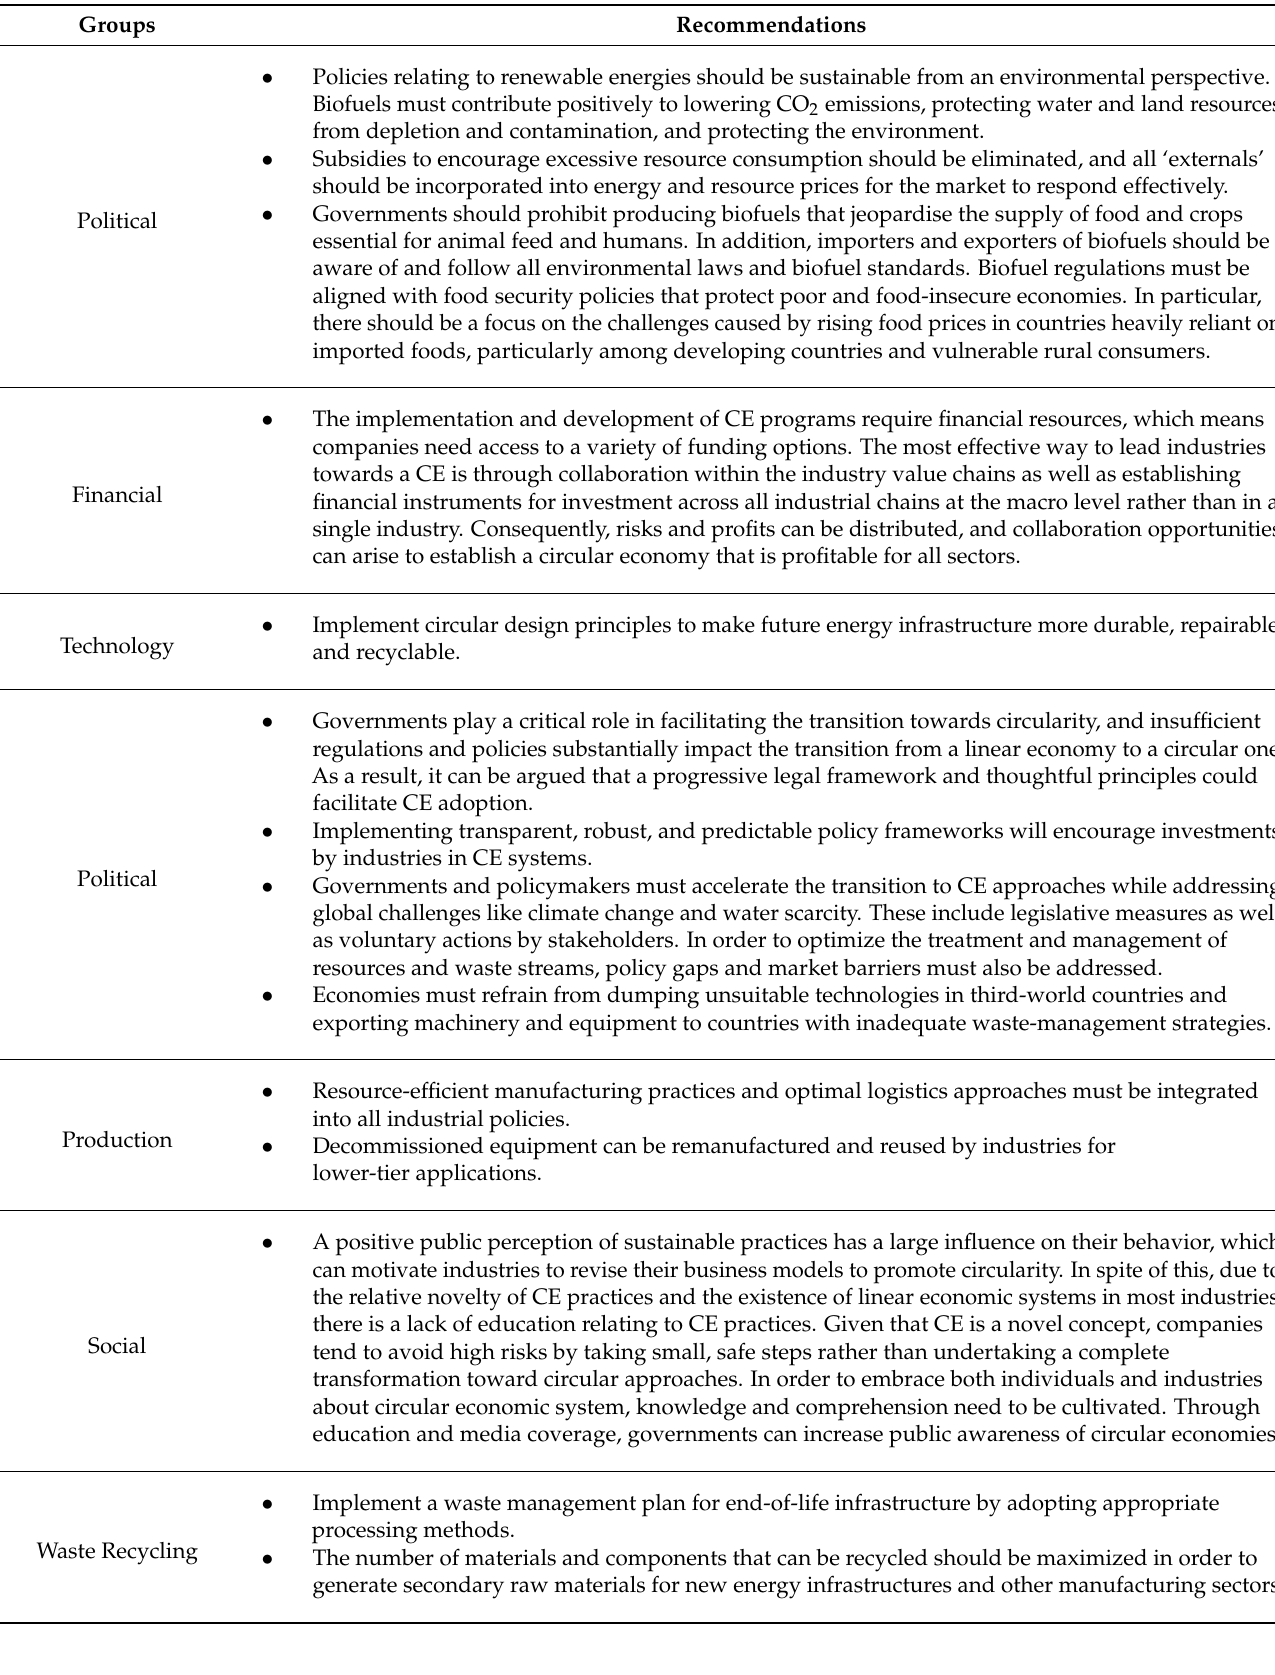
Table 4. Recommendations and